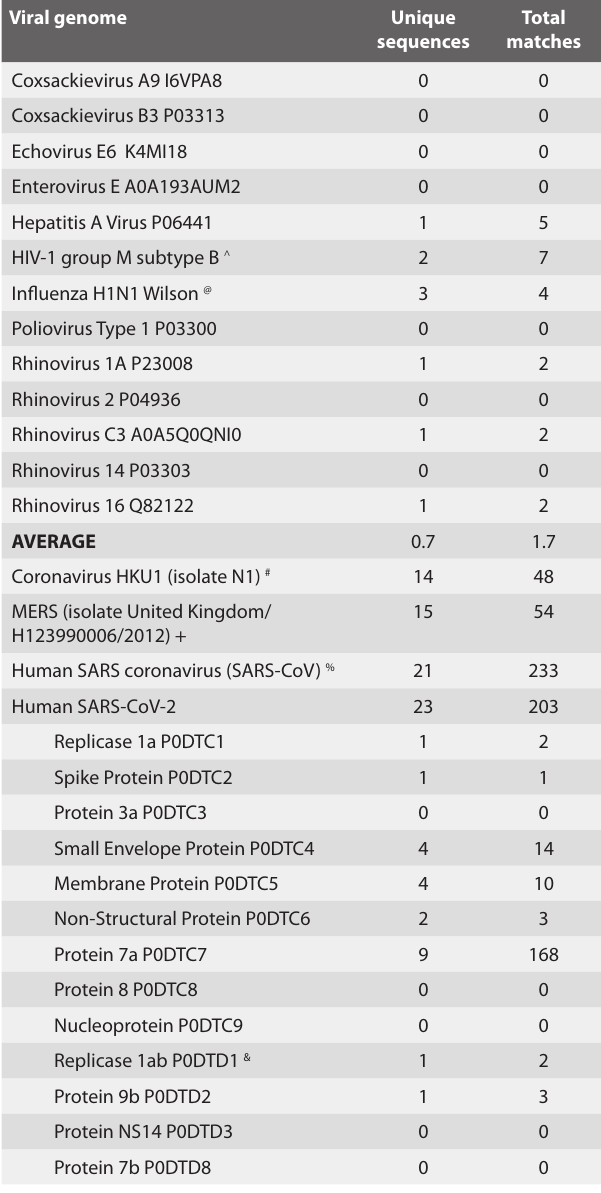
Table 1. Summary of BLAST results comparing virus proteomes with human olfactory receptors.” Unique sequences” are similarities that are distinct in the region of the olfactory receptor that any given virus protein matches. In most cases, a given virus protein matched more than one olfactory receptor, which is indicated in the number of “total matches”.